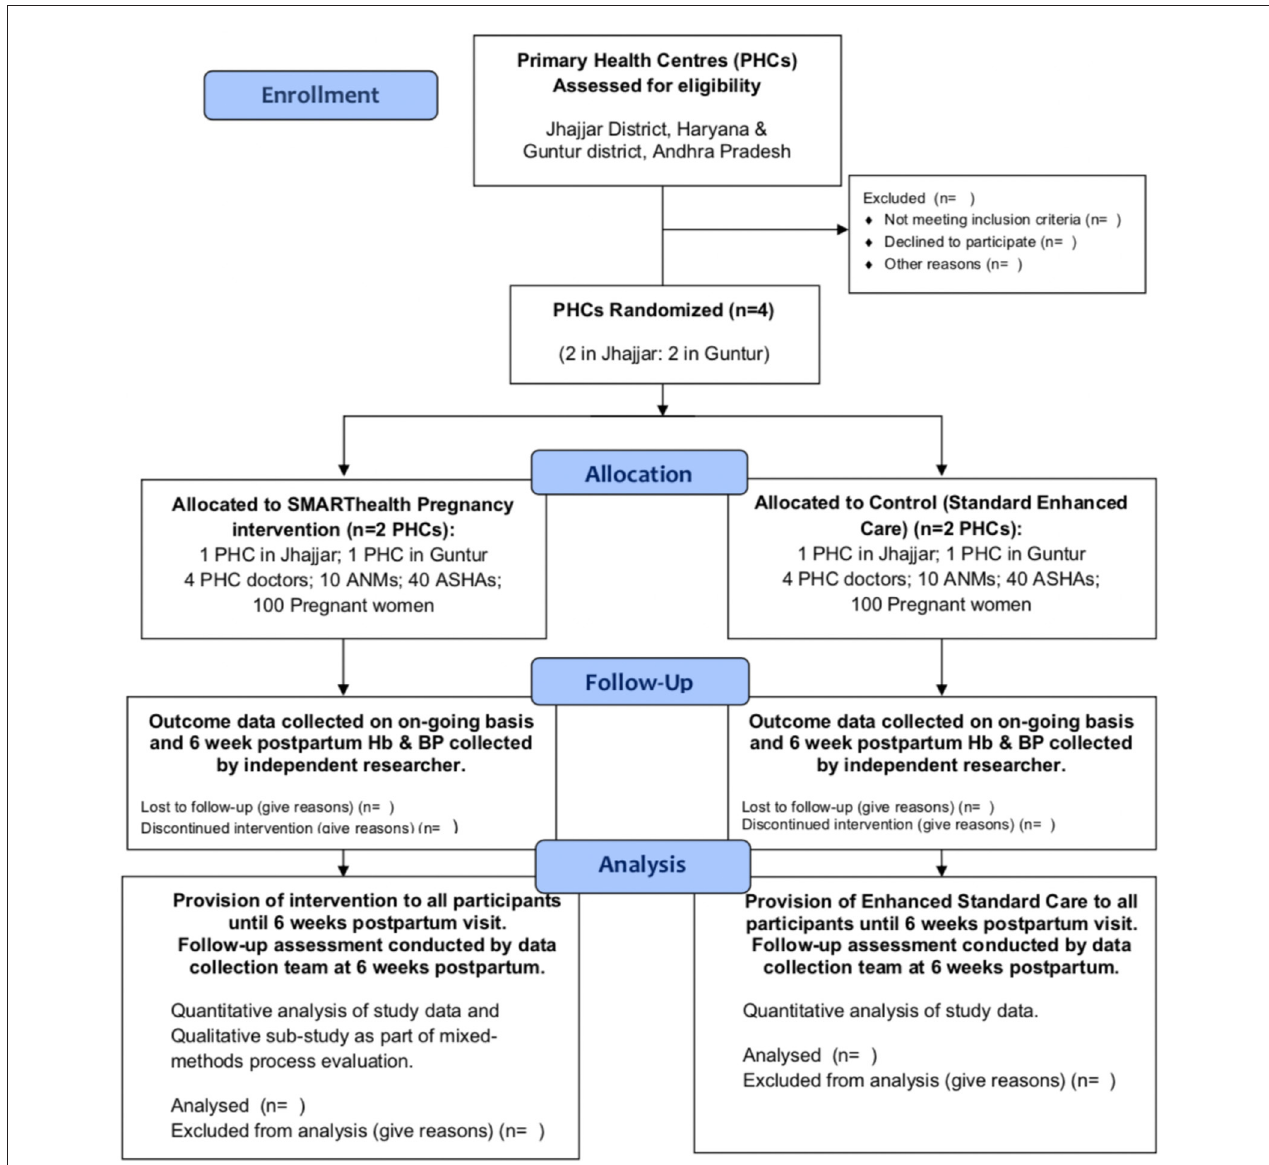
FIGURE 1 | Participant flowchart of pilot